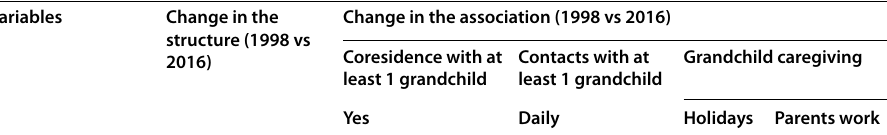
Table 5 Visual summary of main results (RQ1 and